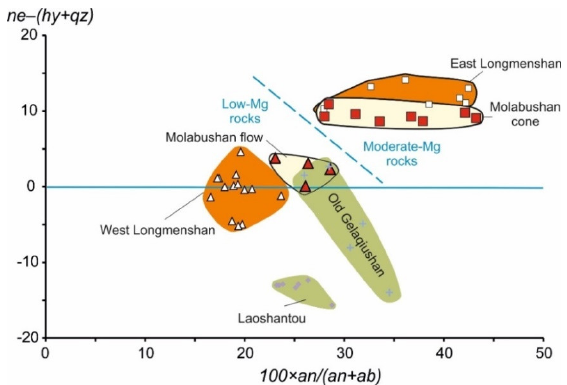
Figure 7. Division of low- and moderate-Mg rocks on a diagram of CIPW normative minerals. Symbols are as in Figure 5. Normative minerals: ne —nepheline, hy —hypersthene, qz —quartz, an —anorthite, ab —albite.